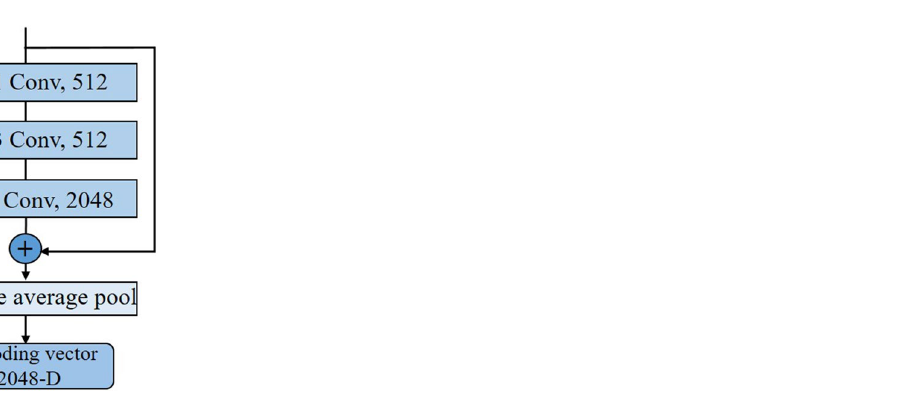
Figure 4. Diagram of obtaining the encoding vector. The adaptive average pooling layer flattens the output feature map into a 2048-dimensional (D) encoding vector to represent the key region image